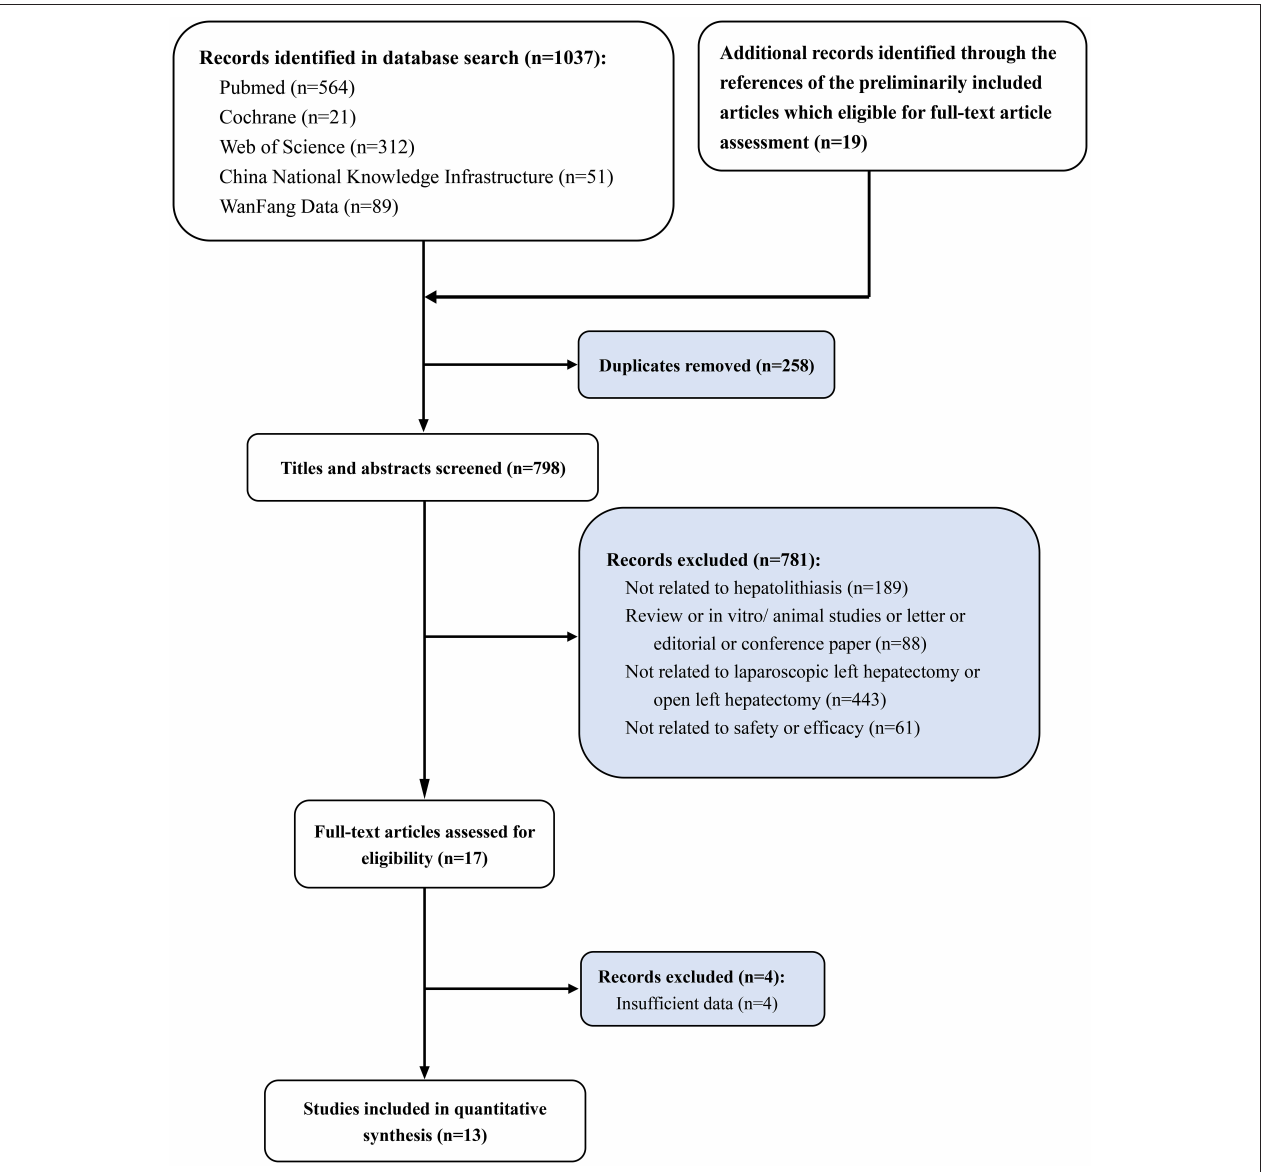
FIGURE 1 | Study selection flowchart, systematic review, and meta-analysis of comparison of the safety and efficacy of laparoscopic left lateral hepatectomy and open left lateral hepatectomy for hepatolithiasis.